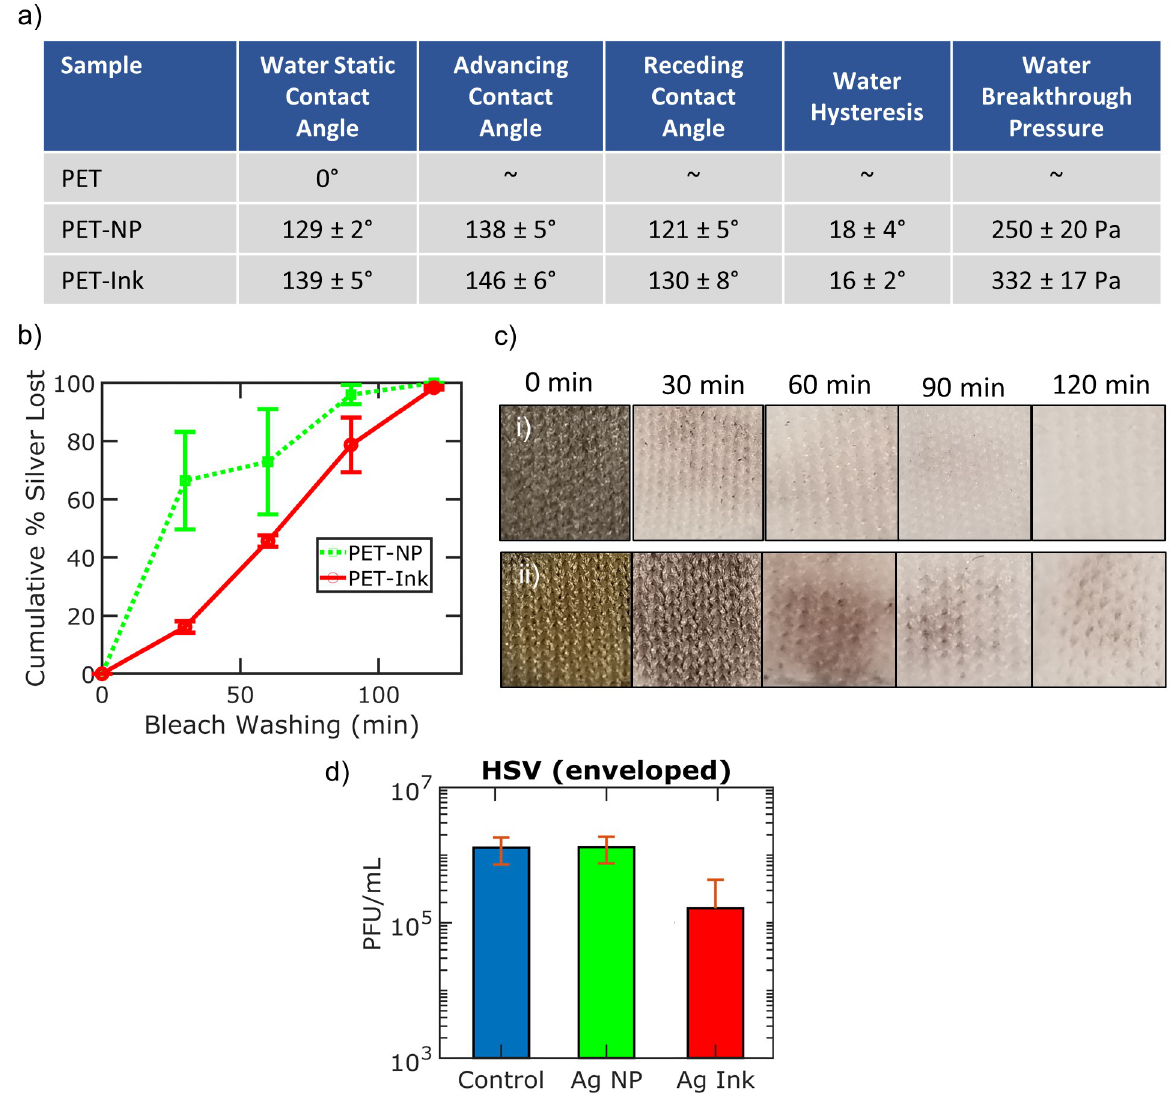
Fig 2. Wash durability of silver coated fabric. a) Wetting characterization for PET, PET-NP, and PET-Ink samples. b) Silver leaching analysis as a function of bleach washing time c) Optical images of (i) PET-NP and (ii) PET-Ink samples as a function of bleach washing time. d) Virus inhibition assay results of silver treatments in